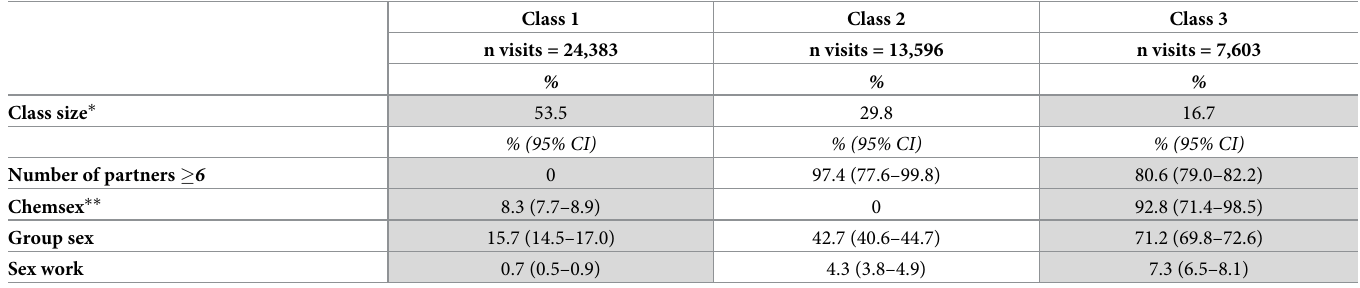
Table 2. Predicted probabilities (in percentages) of class membership and the outcome variables within each latent